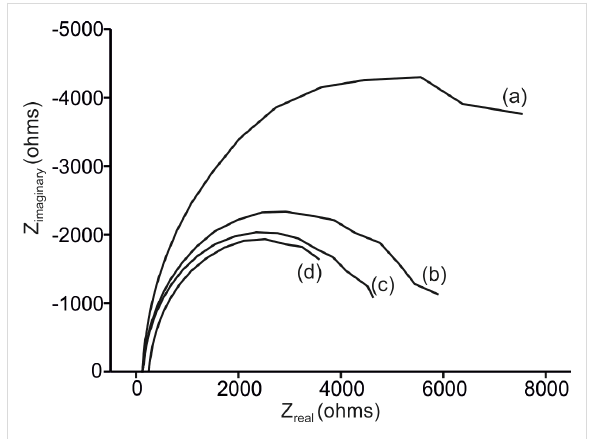
Figure 3: Nyquist plots collected at − 0.5 V using (a) PEDOT/PSS; (b) PEDOT/PSS/CuPc; (c) PEDOT/PSS/LuPc 2 ; and (d) PEDOT/PSS/ AuNP. Electrodes were immersed in catechol 10 − 3 mol·L − 1 with 0.01 mol·L − 1 phosphate buffer (pH 7.0) as the supporting electrolyte. The frequency was swept logarithmically from 10 − 2 to 10 5